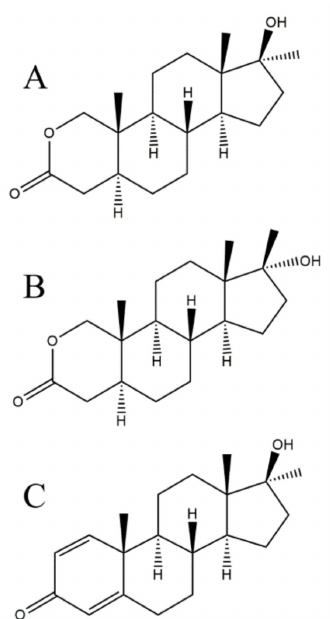
Figure 1. Chemical structure of ( A ) oxandrolone, ( B ) epi-oxandrolone, and ( C ) the methandienone as